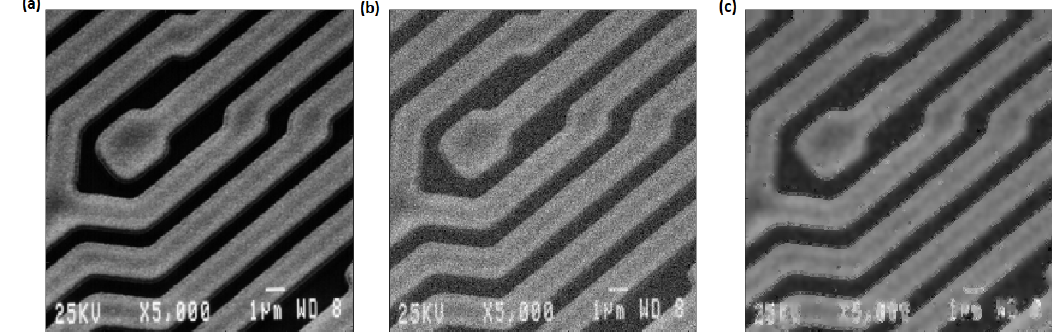
Figure 17. ( a ) Original image, ( b ) Image with the addition of Gaussian white noise (Input PSNR = 22.11 dB), ( c ) Denoising with proposed method (Output PSNR = 26.12 dB).